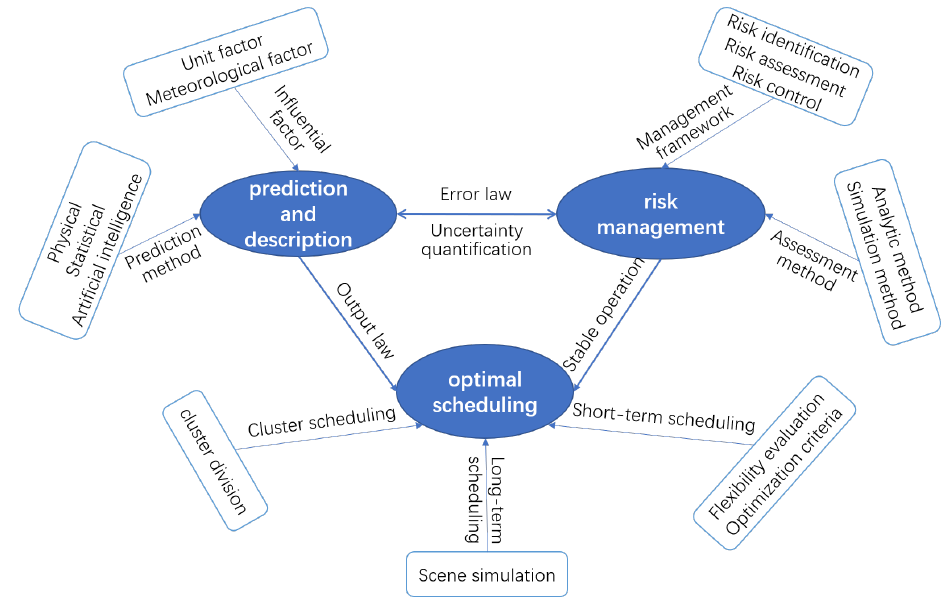
Figure 5. General overview of research